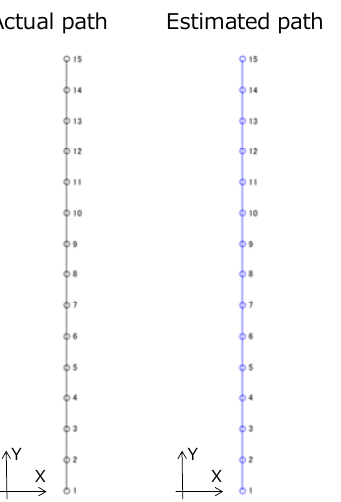
Figure 6. Camera translation estimation result, Corridor 1 (Left image: actual camera path, right image: our estimated result) The estimated camera translation in Corridor 2 is shown in Figure 7. Horizontal axes indicate estimated camera positions, and vertical axis indicates image identification numbers. Although the actual camera path was a straight line, the estimated path meandered around the straight line.